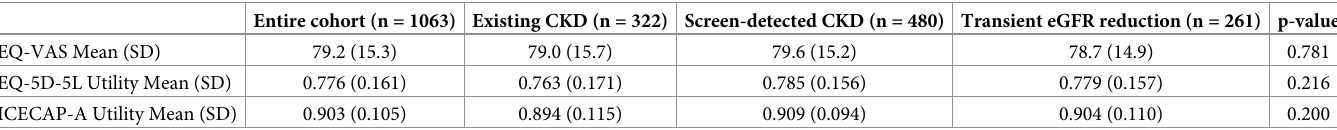
Table 2. Mean questionnaire scores in the entire OxRen cohort of older adults from Oxfordshire primary care practices and stratified by CKD